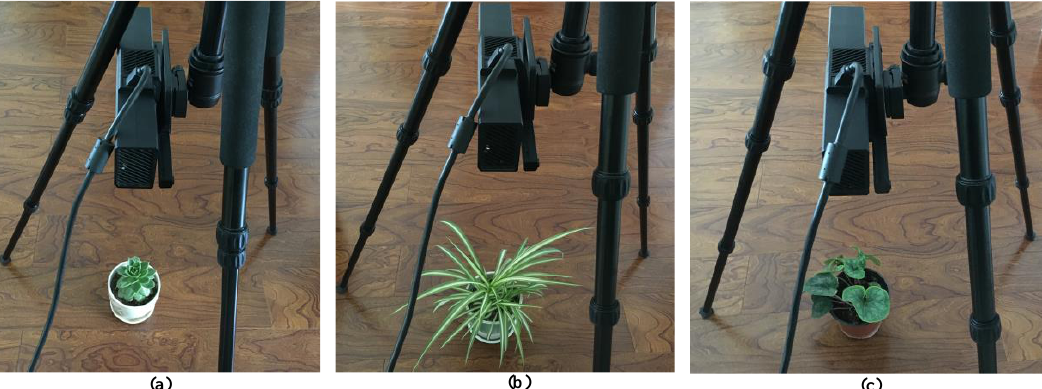
18 of 23 Figure 13. Data distribution and fitting results for cucumber seedling height ( a ) and projected leaf area ( b ). 3.4. Plant Height Precision Measurement